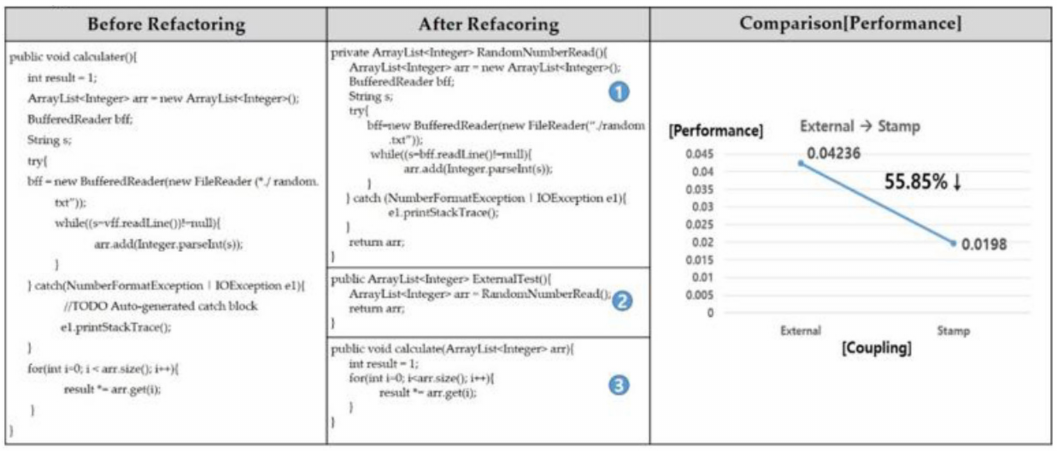
Figure 12. Enhancement of performance after refactoring external into data / stamp coupling.